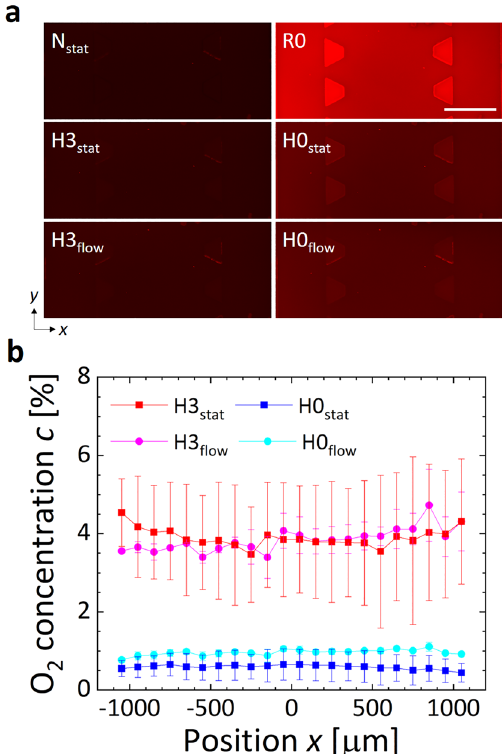
Figure 3. Measurement results of steady oxygen concentration in the microfluidic device. ( a ) Representative microscopic images of phosphorescence from the oxygen-sensing film on the bottom glass cover slip and ( b ) profiles of steady oxygen concentration c across the media and gel channels. Under the conditions N stat and R0, the same gas mixtures containing 21 and 0% O 2 were supplied to the gas channels and the stage incubator, respectively, without media flow. In the hypoxic H3 stat and H0 stat conditions, gas mixtures containing 3 and 0% O 2 were supplied only to the gas channels without media flow, respectively, while in the hypoxic H3 flow and H0 flow conditions, the same gas mixture was supplied to the gas channels and the stage incubator with media flow at Q m = 100 µl/min. Scale bar shows 500 μm. Error bars show the standard